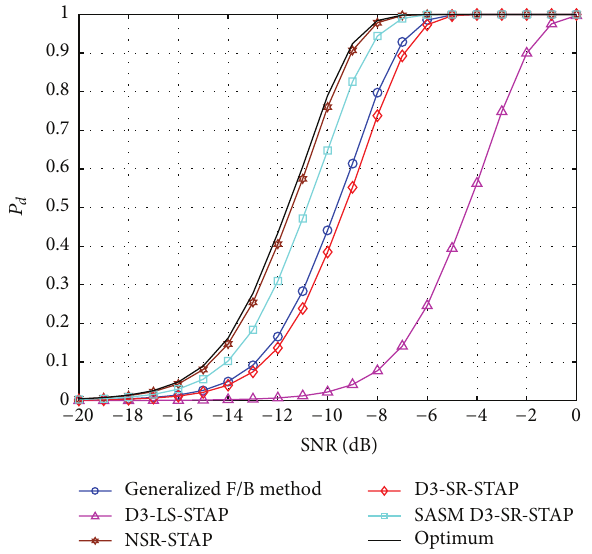
Figure 9: 𝑃 𝑑 versus the target SNR considering ICM.